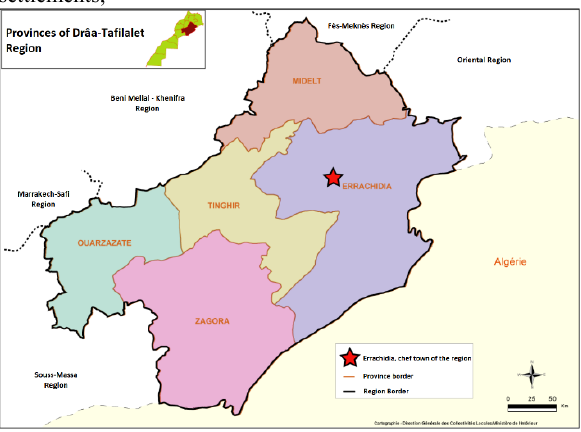
Figure 1 . Provinces of Draa-Tafilalet Region 1.